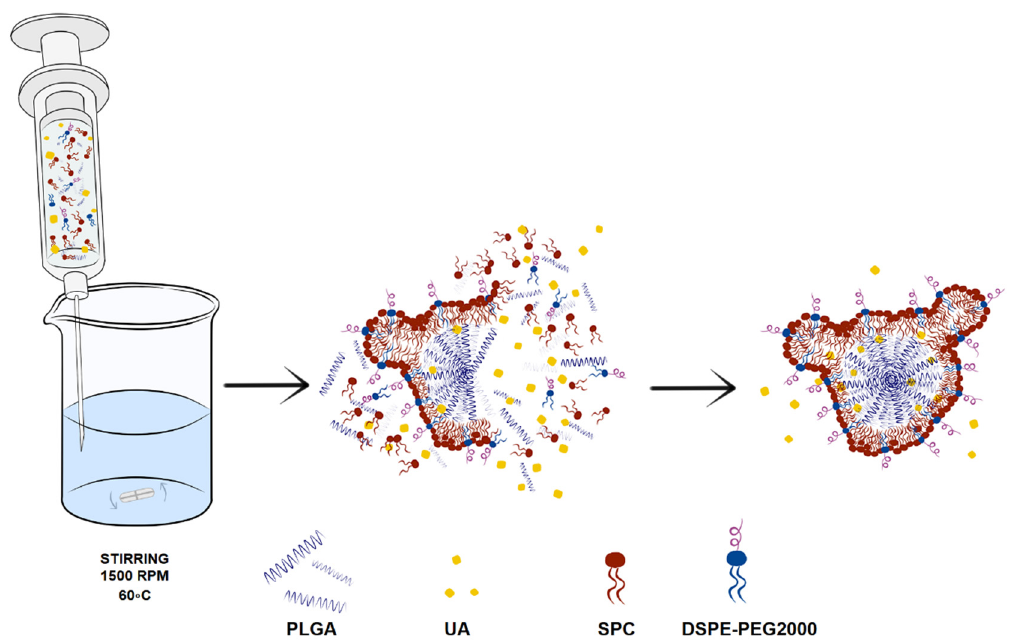
Figure 21. Schematic diagram representing preparation of UA-S85-PLGA-PEG 2000 hybrid nanopar- ticles by the nanoprecipitation method. In the first stage, PLGA, lipids, and UA are injected into Milli-Q ultrapure water under constant stirring and heating. Hybrid UA-loaded PLGA/lipid particles are formed spontaneously with UA entrapment during particle formation.